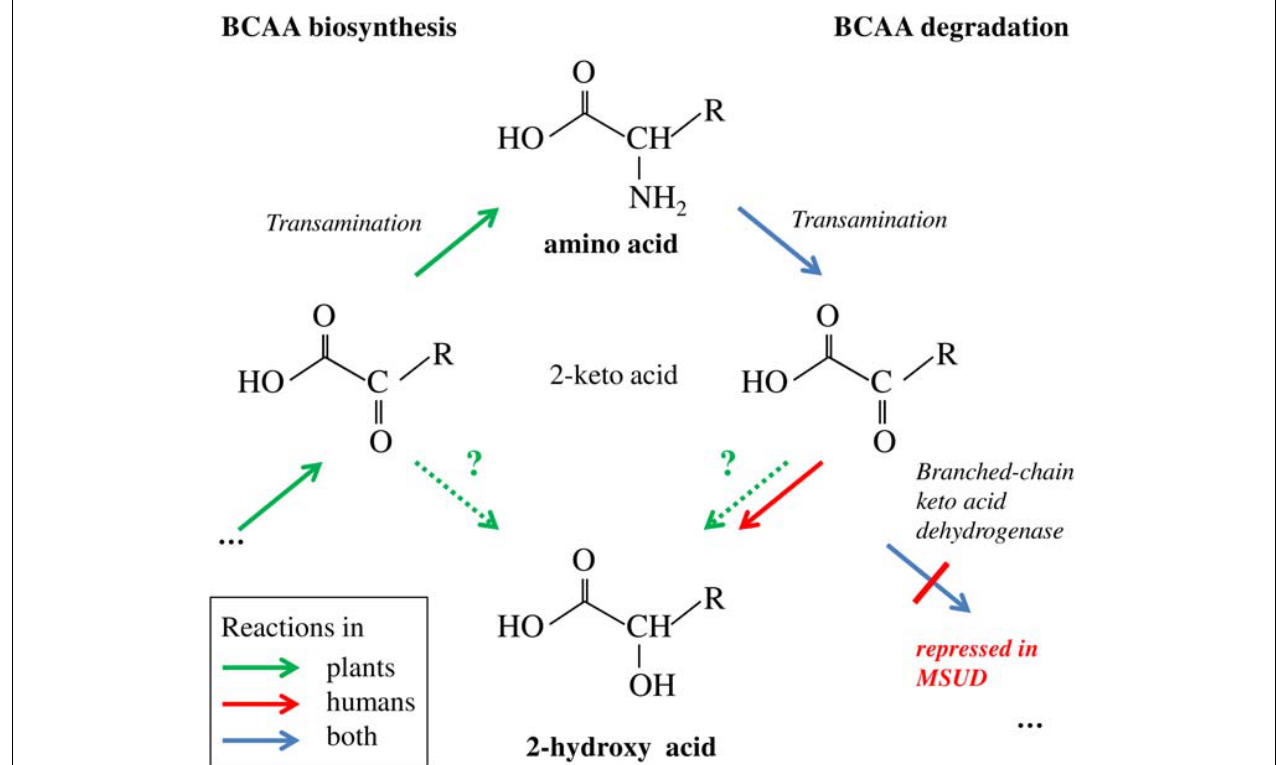
FIGURE 8 | Branched-chain amino acid biosynthesis and degradation and putative link to 2-HA biogenesis. Plants, but not humans are able to synthesize BCAAs de novo involving transamination of the 2-keto acid precursor. Degradation in humans and plants involves the reverse transamination reaction leading to 2-keto acids. In MSUD the subsequent oxidative decarboxylation is repressed due to mutations in the branched-chain keto acid dehydrogenase complex; the accumulating 2-keto acids are in part reduced to 2-HAs (Chuang and Shih, 2001). In plants, the biosynthesis of BCAA-related 2-HAs is not known; however the corresponding 2-keto acids from biosynthetic or catabolic pathways are putative precursors (indicated by stippled arrows and question marks). R = CH(CH 3 )-C 2 H 5 for Ile and derivatives, = CH 2 -CH(CH 3 ) 2 for Leu and derivatives, = CH(CH 3 ) 2 for Val and